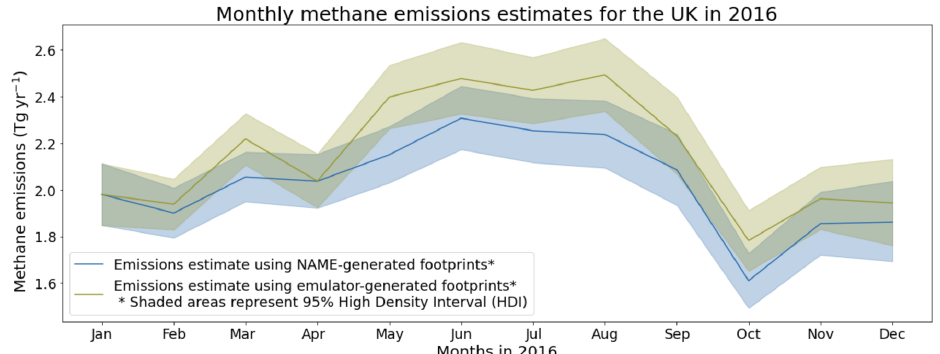
Figure 7. Monthly UK methane emission estimates using the NAME-generated footprints for the five sites in the DECC network (UK and Ireland sites) and the emulator-generated footprints (with NAME-generated values outside of the emulated region) for the same sites.